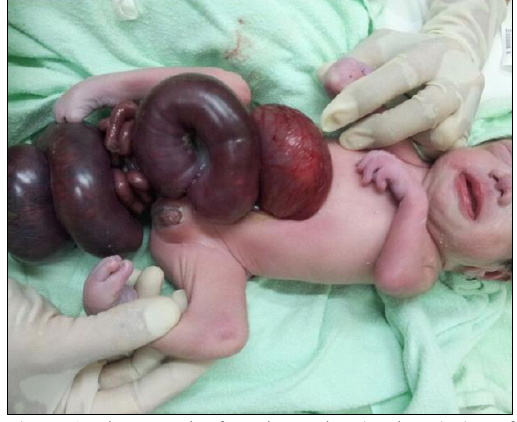
Figure 2. Photograph of newborn showing herniation of twisted and dilated coils of intestines through a right paraumbilical wall defect with associated deformed limbs (Case